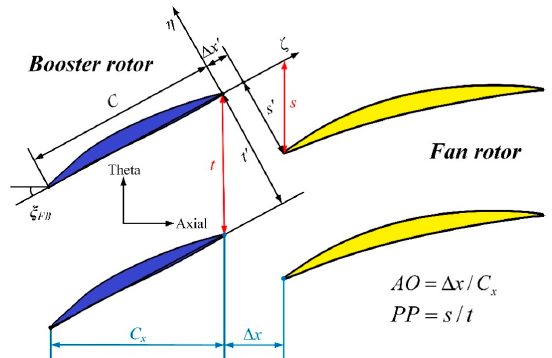
Figure 2. Schematic of the key design parameters inside the tandem rotor.